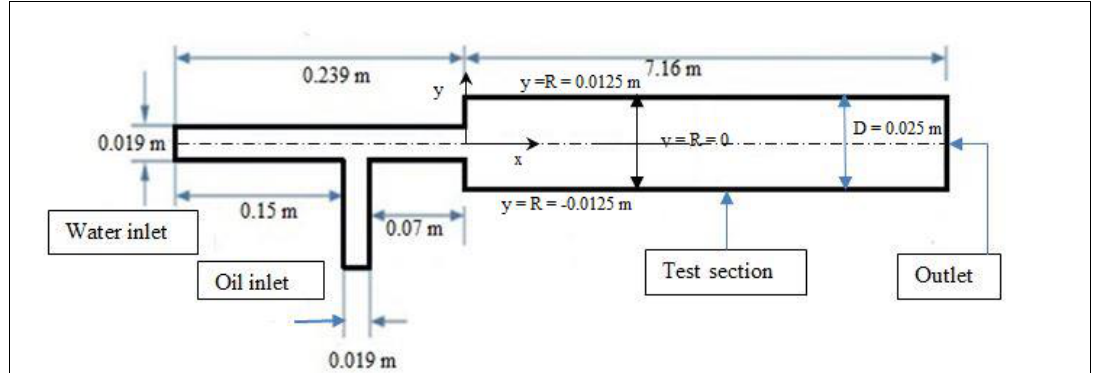
Figure 1. Plan representation of 2D channel domain